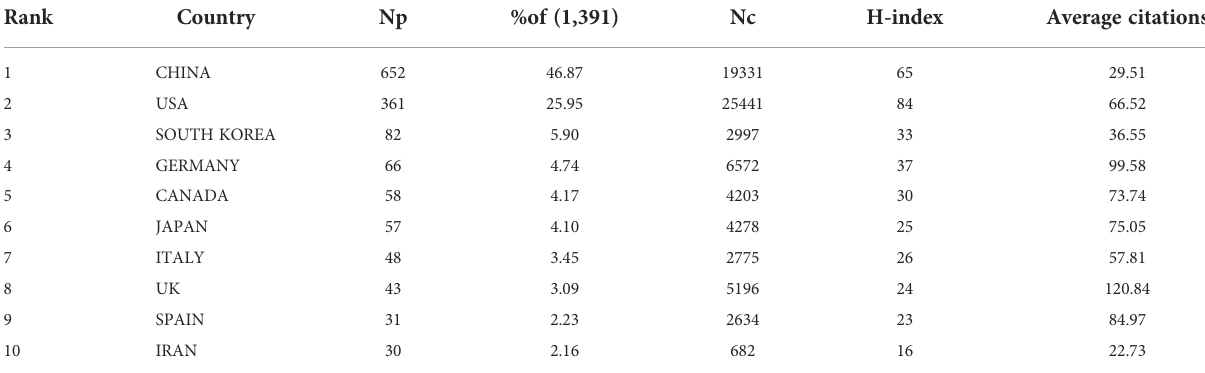
TABLE 1 Top 10 most productive countries.